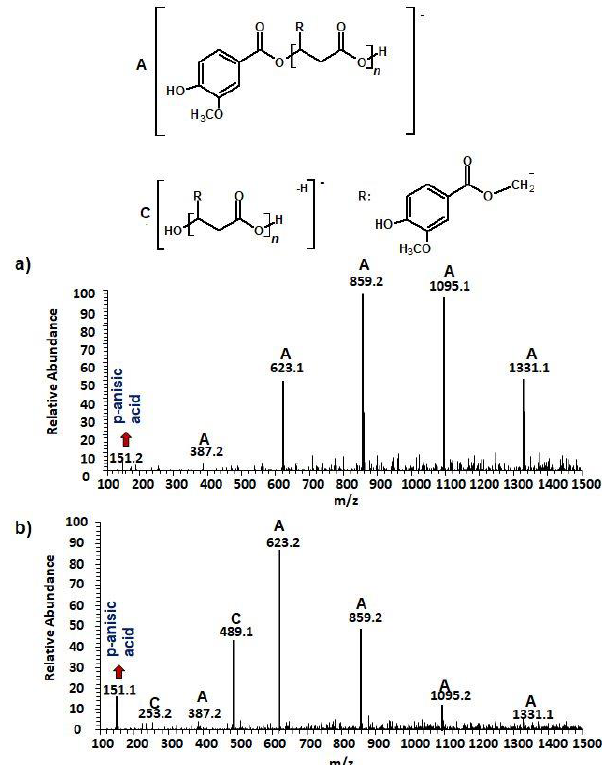
Figure 2. The negative electrospray (ESI) mass spectra of aqua solutions of the (p-AA-CH 2 -HP) n (sample 1) ( a ) and medium collected after hydrolytic degradation (14 days) of the (p-AA-CH 2 -HP) n at 37 °C together with chemical structures of the ions derived from series A and C ( b ).